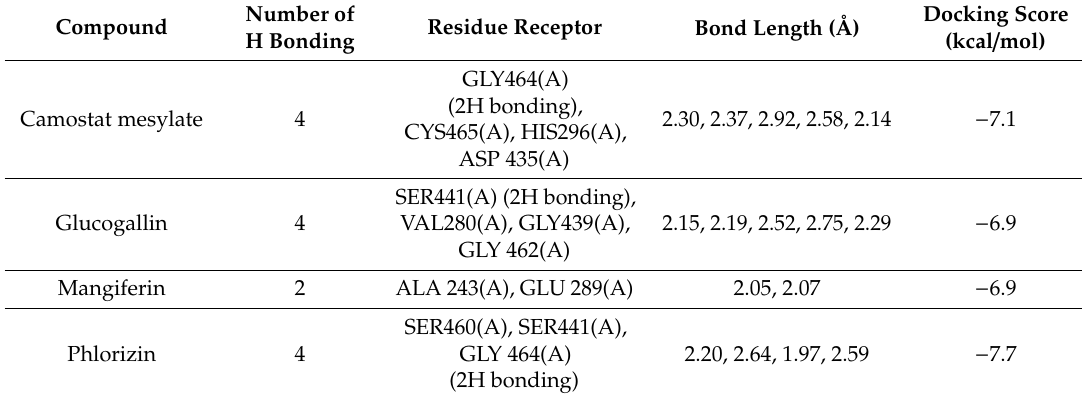
Table 2. Predicted interactive residues of TMPRSS2 with